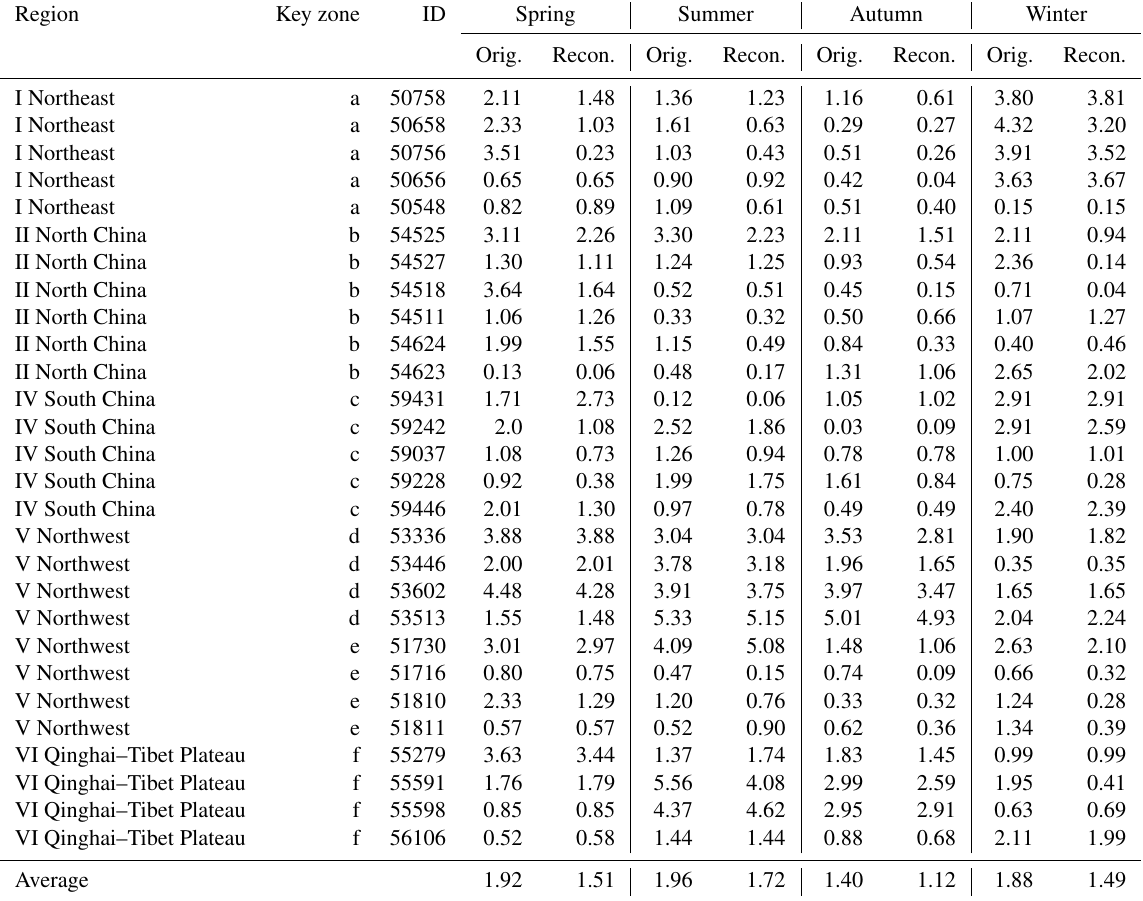
Table 2. RMSEs of seasonal LST between monthly LST data (including the original LST data and reconstructed LST data) and ground-based LST data (Orig. indicates original LST values at the ground stations; Recon. indicates the reconstructed LST values at the ground stations). Region Key zone